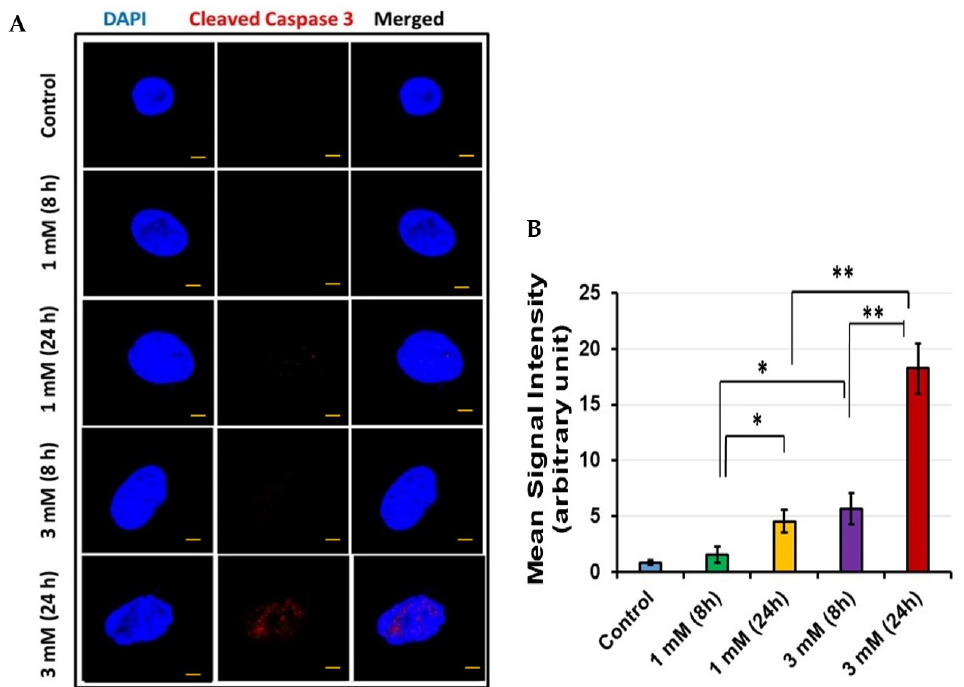
Figure 5. Cleaved caspase 3 immunostaining: ( A ) Representative photomicrographs showing cleaved caspase 3 expression levels in HEI-OC1 cells treated with gentamicin. Red: cleaved caspase 3; Blue: cell nuclei. Scale Bars: 20 µM; ( B ) ImageJ software was used to determine mean signal intensity for cleaved caspase 3 immunostaining. * p < 0.05 or ** p < 0.01.